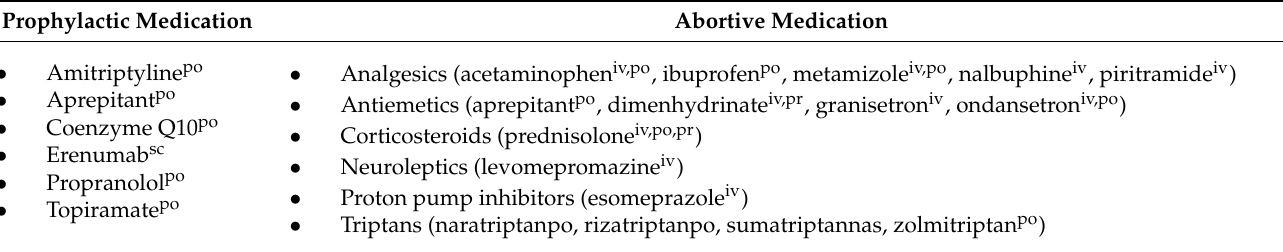
Table 2. Prophylactic and abortive